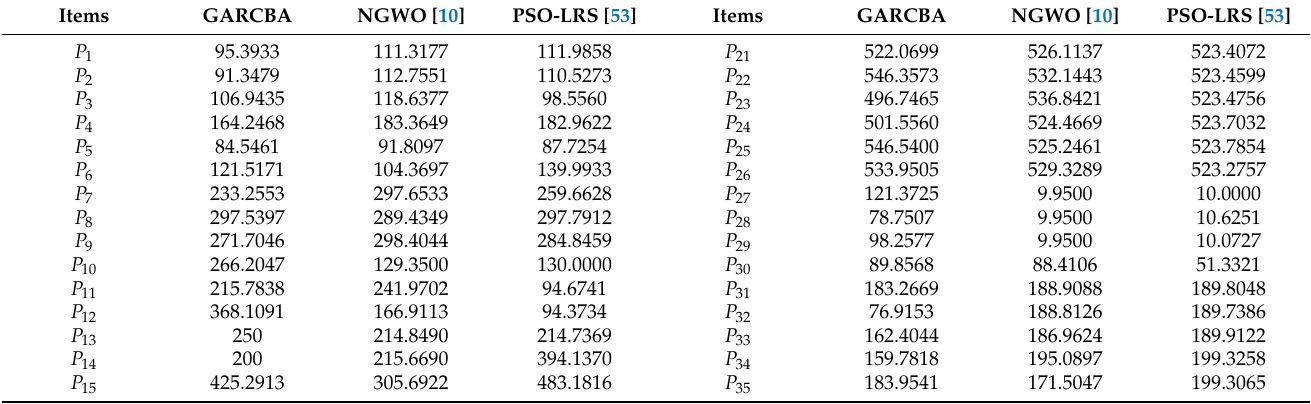
Table 11. Best cost solutions for Case